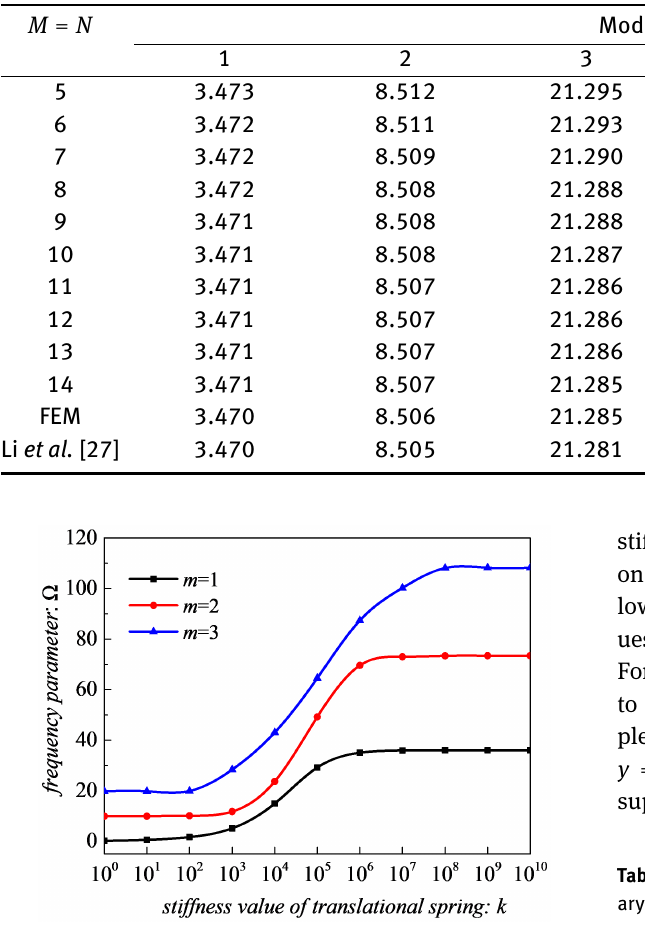
Figure 3: Realtionship between Non-dimensional frequency parame- ters snd stiflness of translational springs